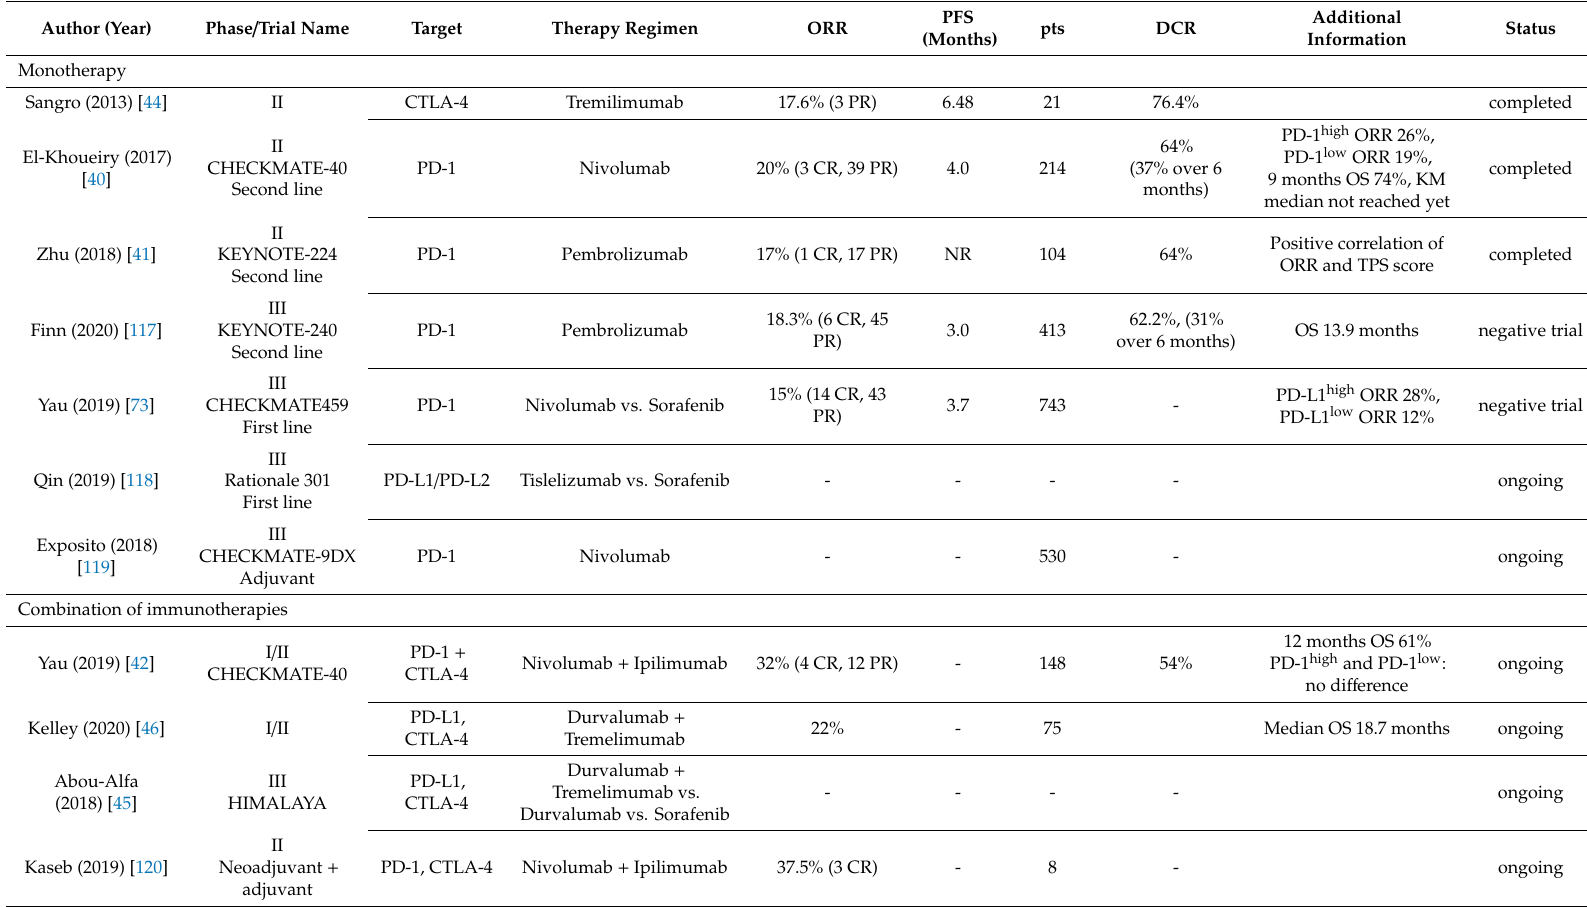
Table 2. Summary of clinical trials for immunotherapy (mono- and combination therapies / completed and ongoing) in